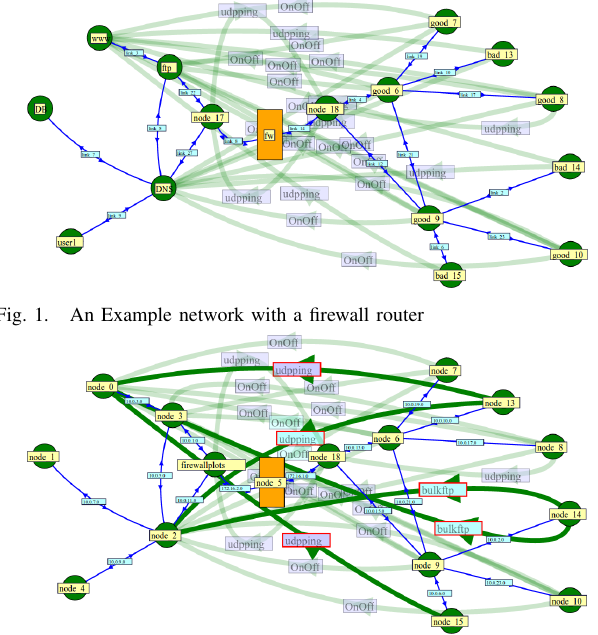
Fig. 2. The bad traffic (highlighted) to be blocked by the firewall deterministically spaced UDP packets, and long-running ftp